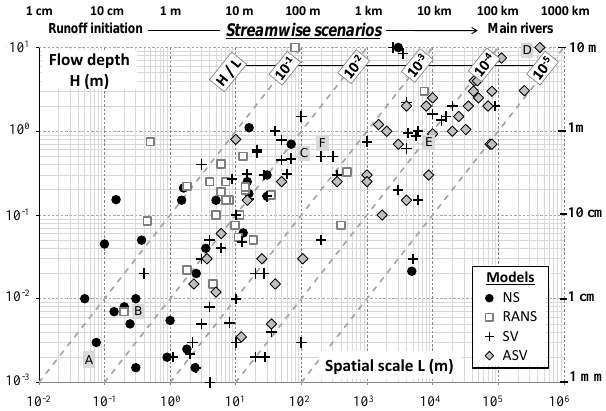
Figure 3. How increasing ( L , H ) spatiotemporal scales of the flow domain tend to be associated with decreasing complexity in the choice of flow models, sorted here into four levels of refinement: Navier–Stokes (NS), Reynolds-averaged Navier–Stokes (RANS), Saint-Venant (SV), and approximations to Saint-Venant (ASV). A transverse analysis involves forming H/L ratios, searching for clues to model selection according to the “fineness” of the flow or governed by flow typologies that would exhibit specific H/L